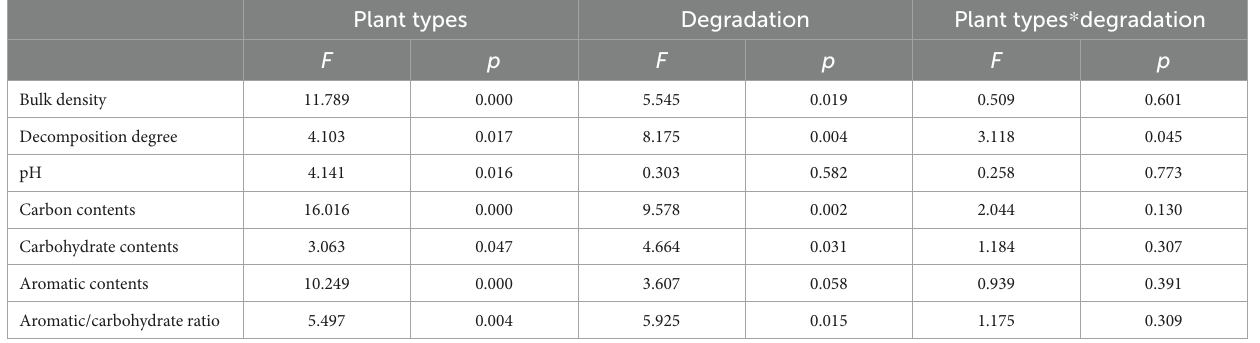
TABLE 2 Two-way ANOVA for typical physicochemical properties, carbon contents, and carbon compounds in peat